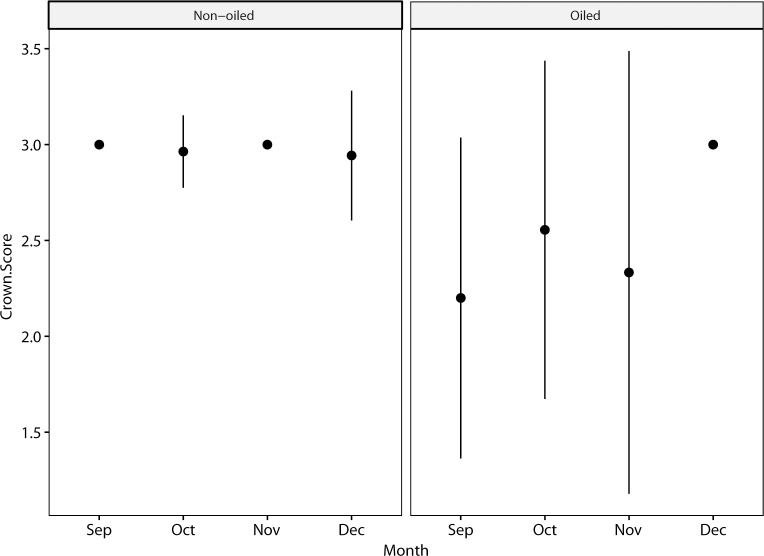
Crown scores compared for non-oiled and oiled pelicans, showing monthly mean and standard deviation.The oiled group includes pelicans released with band-only and GPS-PTT tags (N = 21). The non-oiled group includes only unmarked pelicans (N = 135) and does not include pelicans bearing PTT tags. Data are from September 15-December 15, 2015. Statistical analysis results are presented in Table 1.